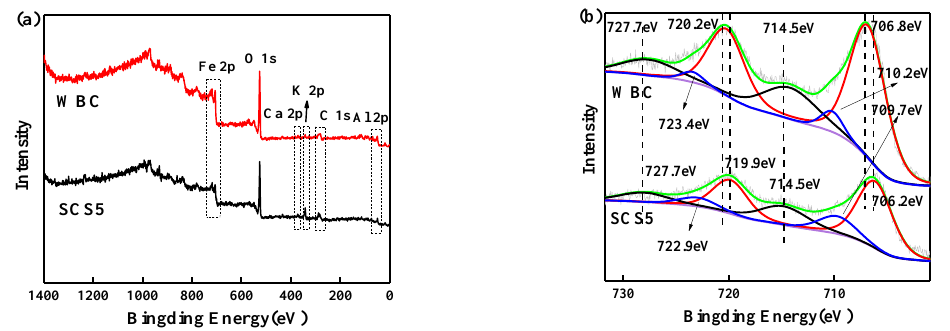
Figure 6. XPS spectra of reduced SCS5 and WBC catalyst; ( a ) the analysis of elements, ( b ) binding energy of Fe2p.